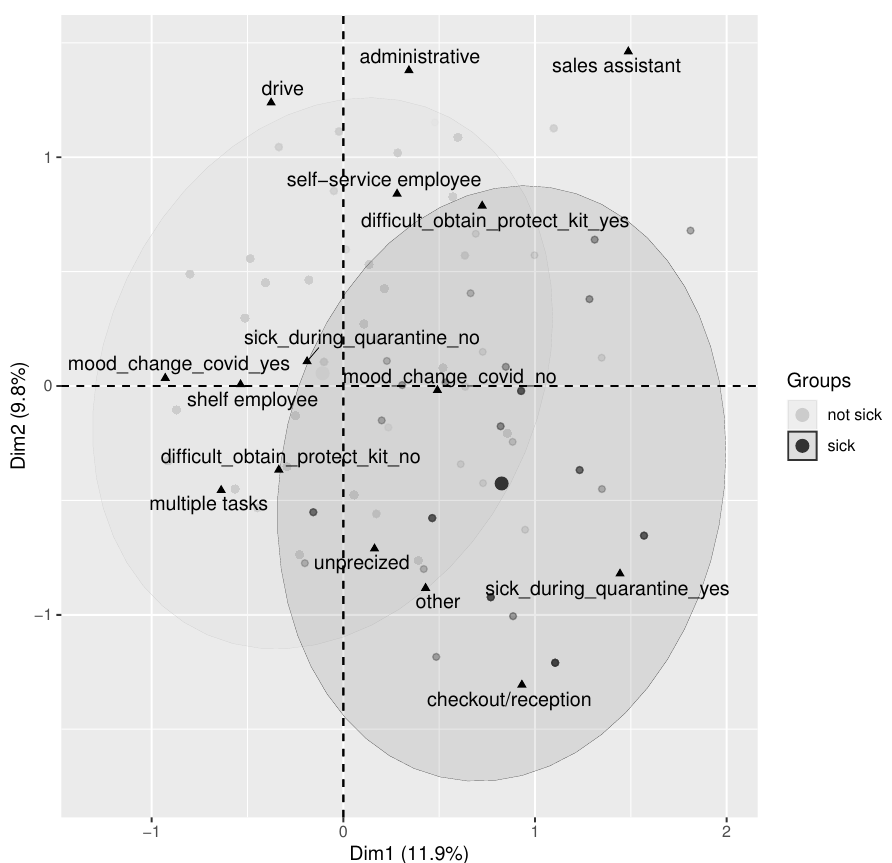
Figure 2. Multiple correspondence analysis ( n = 1519). The two first factorial dimensions are presented (a proportion of total explained variance is indicated for each axis); groups of sick and non- sick employees during the lockdown are indicated by the 95% confidence ellipses. The considered variables are: being or not being sick, having or not having difficulty to obtain a protection kit, position of the employee, and changed or not changed mood during lockdown.